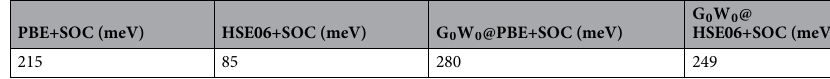
Table 1. Band gap of TlBiSe 2 using different ǫ xc functionals.